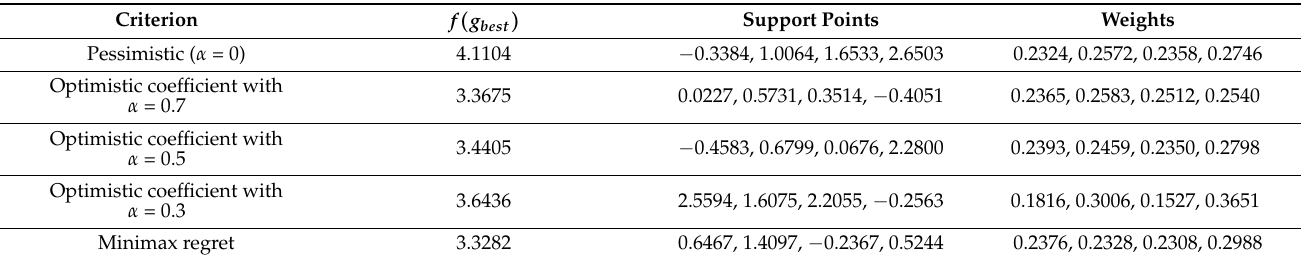
Table 6. Different criterion with two parameter logistic regression